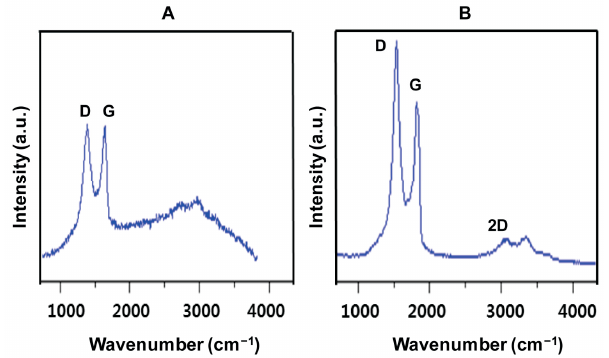
Figure 6. Raman spectroscopy analyses of GO and UA-rGO samples. Raman spectra of GO ( A ) and UA-rGO ( B ) were obtained using laser excitation of 532 nm at the power of 1 mW, after the removal of background fluorescence. The intensity ratios of the D-peak to G-peak were 1.5 and 2.02 for GO and UA-rGO, respectively. At least three independent experiments were performed for each sample and reproducible results were obtained.